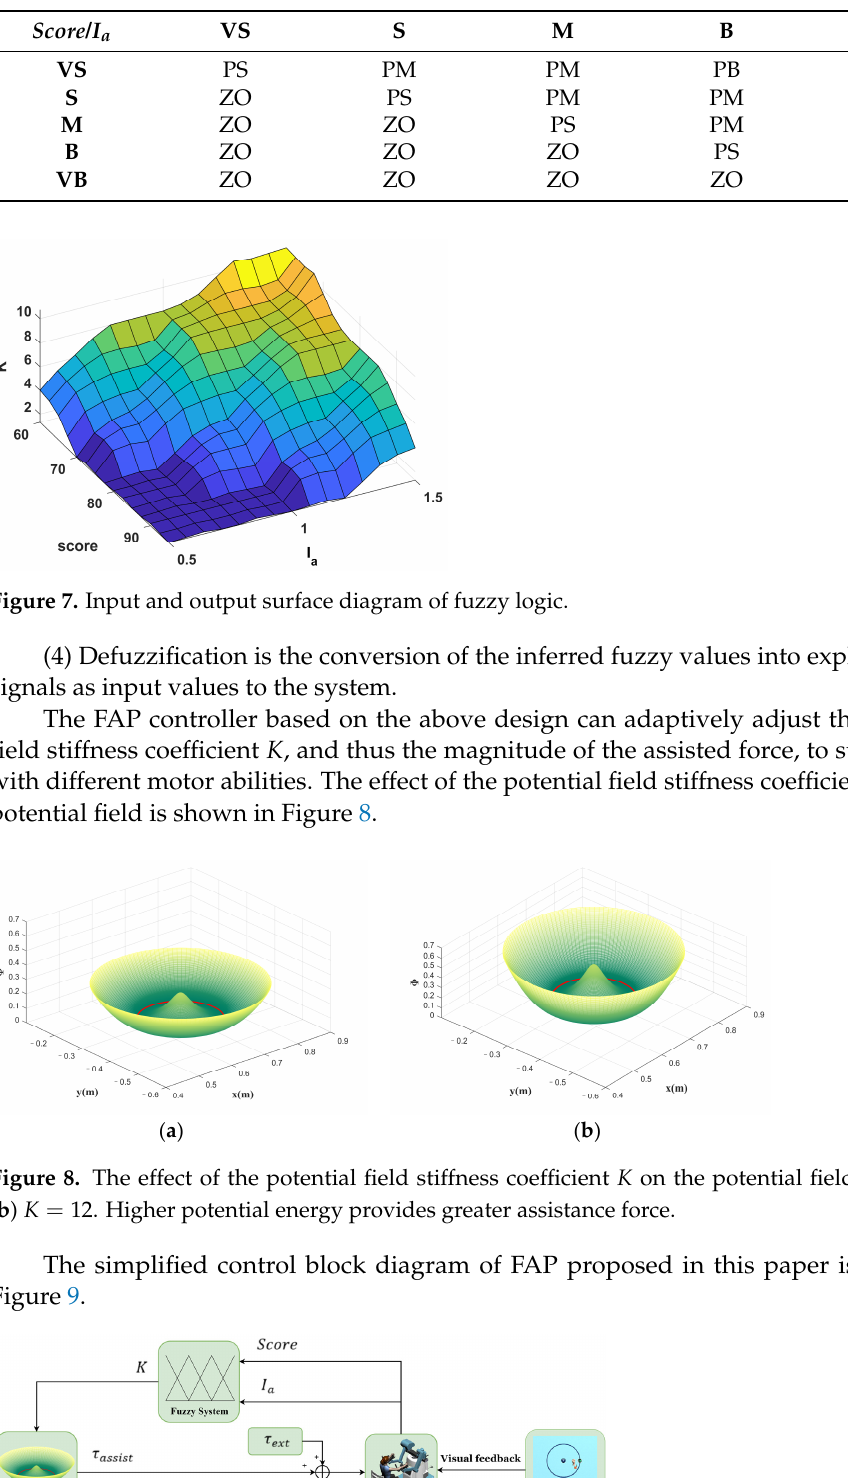
Figure 9. The simplified control block diagram of FAP.